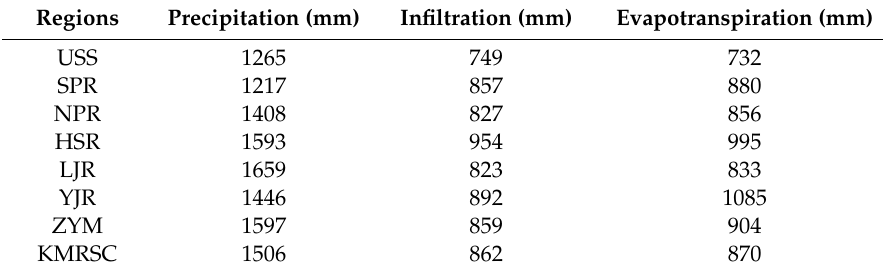
Table 5. Annual average precipitation, infiltration, and evapotranspiration in the Class III WRRs and